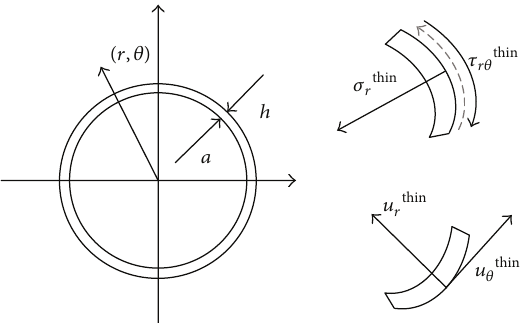
Figure 3: A thin-shell circle computing